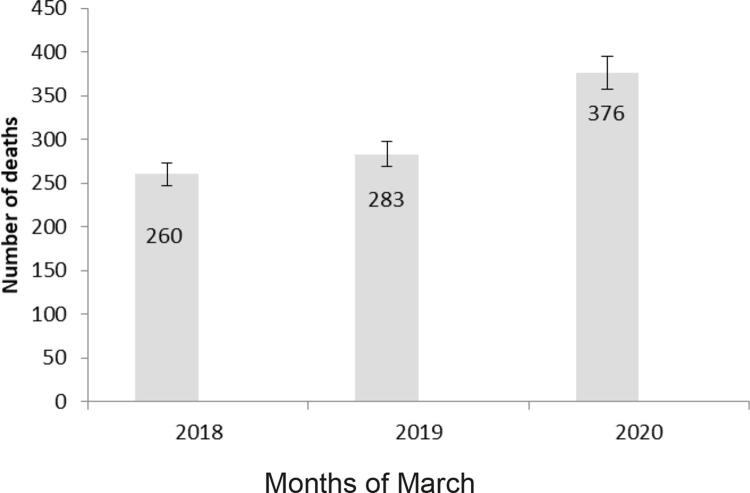
– Prevalence of death outcome in patients assisted by the Mobile Emergency Care Service of Belo Horizonte, Minas Gerais, Brazil, March 2018-2020.